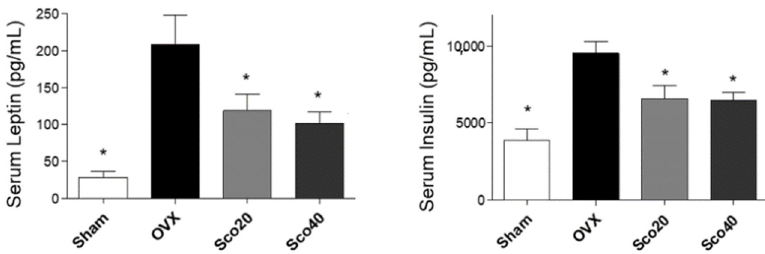
Figure 4. Scopolin decreased serum concentrations of leptin and insulin in OVX-induced obese mice. Blood samples after 12 weeks of non-administration of scopolin (Sham and OVX) and scopolin administration (Sco20 and Sco40 mg / kg / day) were collected and serum levels of leptin and insulin were assessed by ELISA. * p < 0.05 vs. OVX (Tukey’s HSD post-hoc test and ANOVA). Abbreviations: Sham, sham-operated mice; OVX, ovariectomized mice.